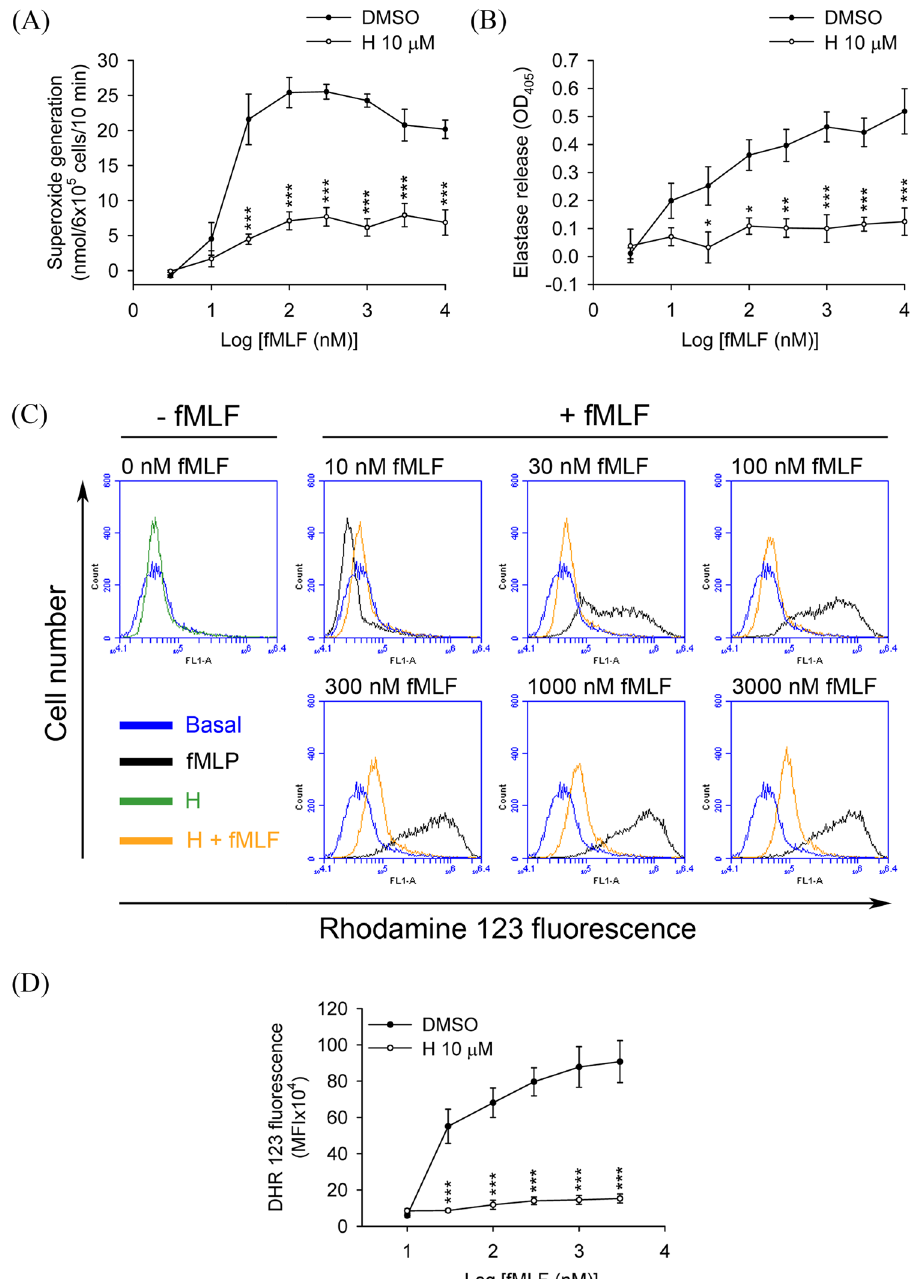
Figure 7. Honokiol inhibits dose–response effects of fMLF in human neutrophils. Human neutrophils were incubated with 0.1% DMSO (as control) or honokiol (H; 10 μ M) for 5 min before the addition of different concentrations of fMLF in the presence of CB. ( A ) Superoxide anion production was measured by assessing ferricytochrome c reduction. ( B ) Elastase release was measured spectrophotometrically at 405 nm. ( C ) Representative histograms of rhodamine 123 are shown. ( D ) Mean fluorescence intensities of ( C ) are shown. All data are expressed as the mean ± S.E.M. ( n = 3–5). * P < 0.05; ** P < 0.01; *** P < 0.001 compared with corresponding